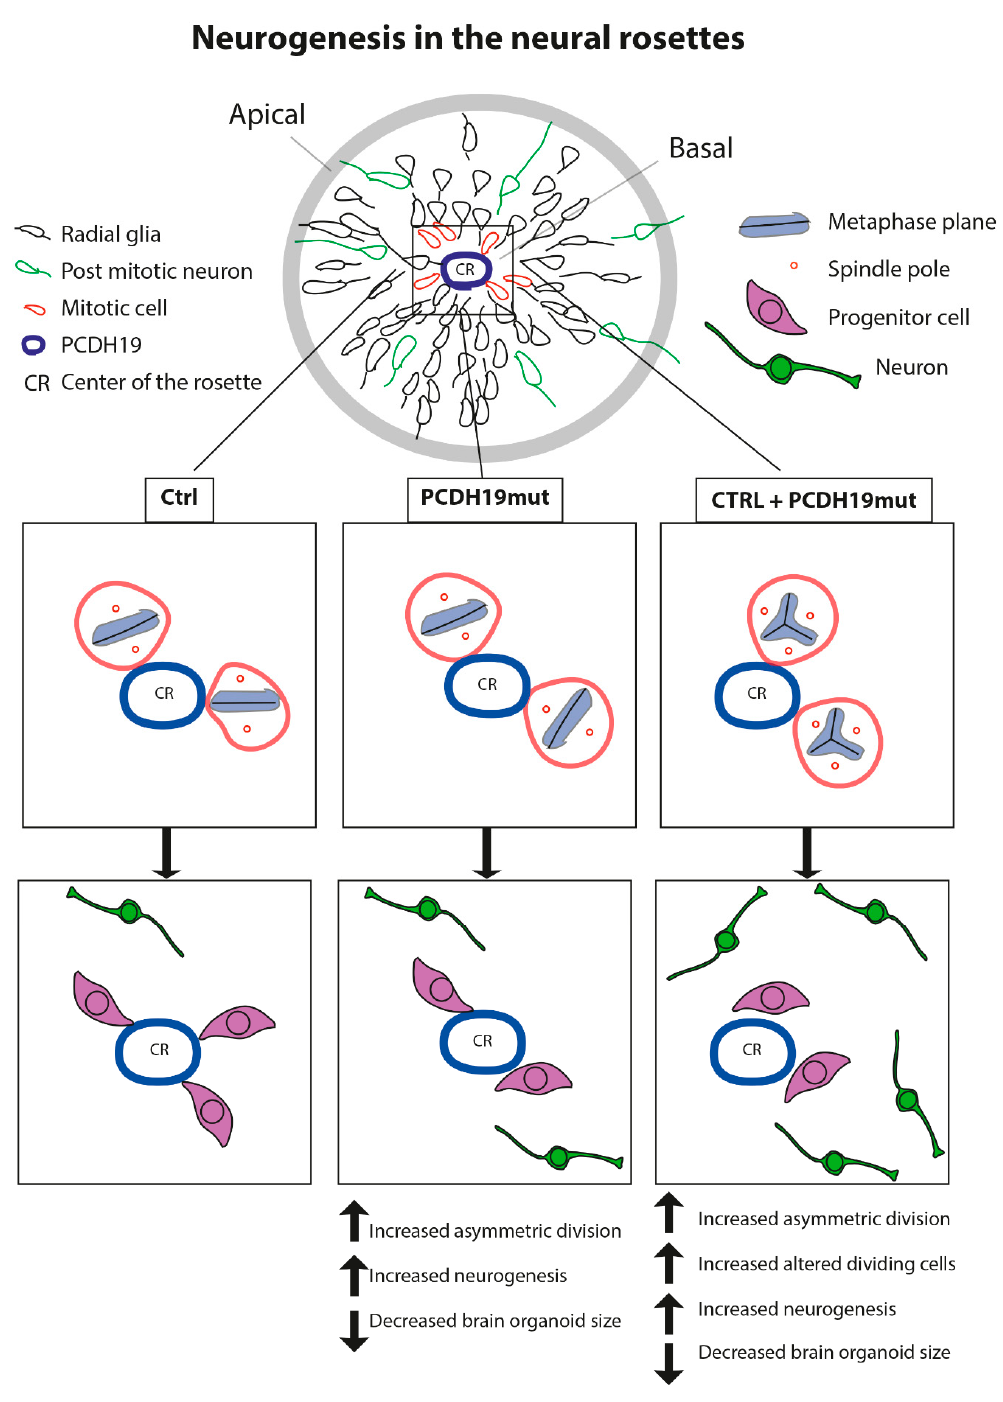
Figure 8. Schematic drawing depicting the model we used to explain the effect of PCDH19 on dividing cells at neural rosette stage in CTRL, PCDH19mut and mixed iPSC cultures. Scheme of a neural rosette showing mitotic cells (in red) close to the center of the rosette (CR) (corresponding to basal zone), post-mitotic neurons (in green) which are migrating away from the lumen and the radial glia (or progenitor cells) toward the apical zone. Boxes show the orientation of metaphase plan in CTRL, PCDH19mut and mixed (CTRL+PCDH19mut) dividing cells. In CTRL rosettes, two cells are dividing: one in a symmetric and the other in an asymmetric way, generating two neural progenitor cells and one progenitor and one post mitotic neuron, respectively (in total, three progenitors and one neuron). In PCDH19mut rosettes, two cells are undergoing asymmetric division, and each generates one progenitor and one post-mitotic neuron (in total, two progenitor cells and two neurons). Mutated PCDH19 is responsible for a “cell autonomous” effect, which induces an increase in